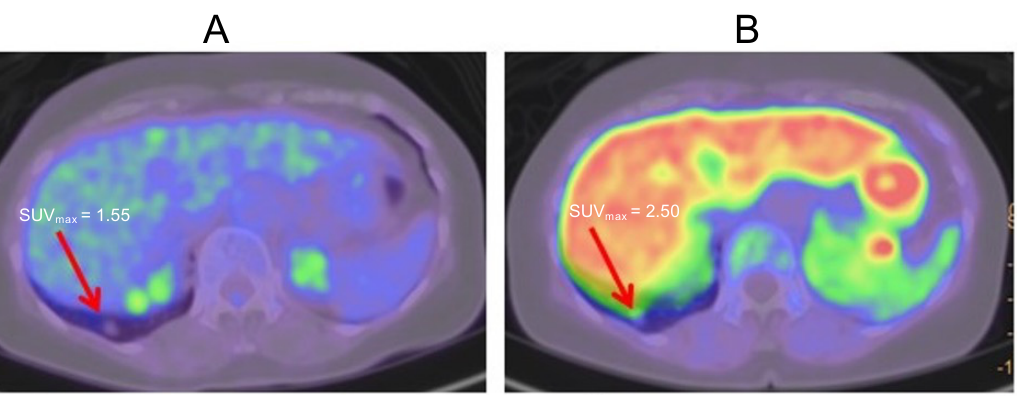
Figure 4. Solitary lung nodule at lower right lung. ( A ): FDG-PET imaging. ( B ): MET-PET imaging. Arrows indicate well-differentiated adenocarcinoma.